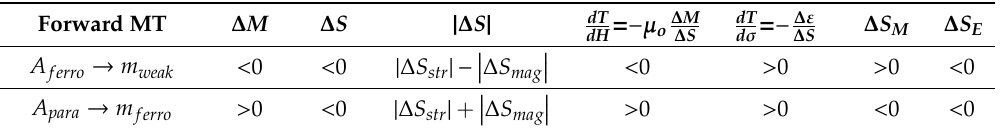
Table 1. Distinctive characteristics of the magnetostructural transformations A ferro → m weak and A para → m ferro . MT, martensitic